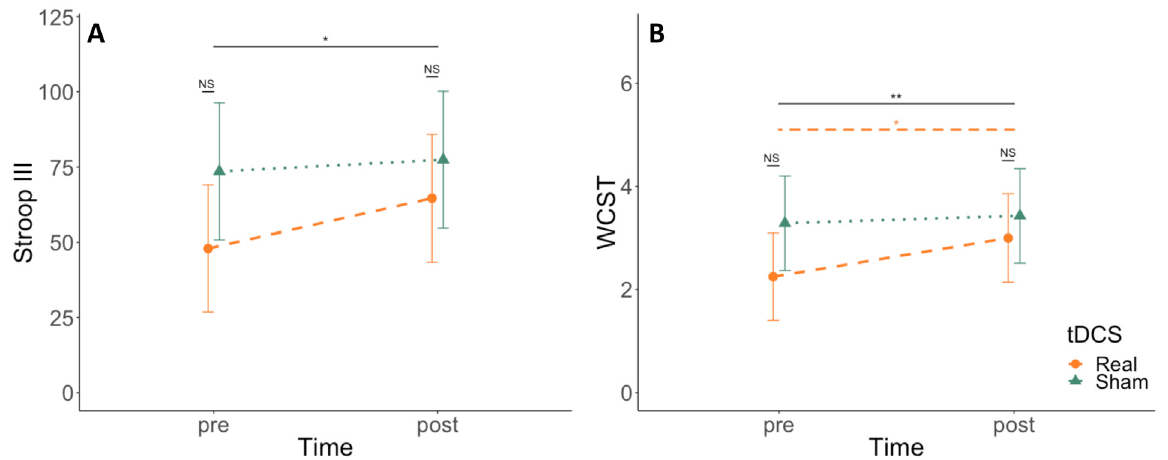
Figure 6. Mean pre- and postscores for inhibition and shifting on A. the Stroop Color-Word test Card III, and B. the Wisconsin Card Sorting Test (WCST), for the sham (dotted, triangles) and real (dashed, circles) group with 95% confidence intervals. Continuous lines indicate main effects, dashed and dotted lines indicate a significant difference between the pre- and postscores of the separate group (real: dashed; sham: dotted) as found by the post-hoc analyses. NS = non-significant; * = p ≤ 0.05; ** = p ≤ 0.01.